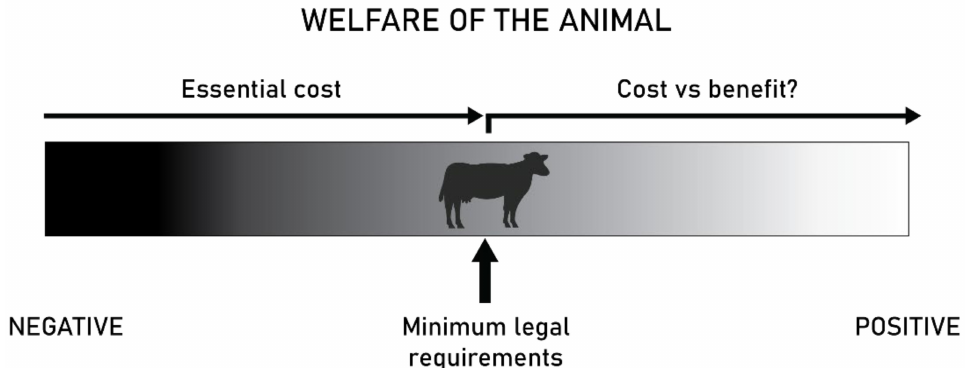
Figure 1. Continuum of animal welfare. The state of an animal’s welfare can vary from negative to positive. While these terms may be considered subjective, with the potential for meaning to change between people and over time, the principle is that there is a continuum of levels of animal welfare. The cost to ensure that the welfare of animals is not negative may be considered an essential cost. The economic advantage from investment to move the level of animal welfare to more positive states on the continuum is challenging to evaluate, although market protection afforded by gaining and maintaining consumer and community support may well justify the costs to ensure positive states of animal